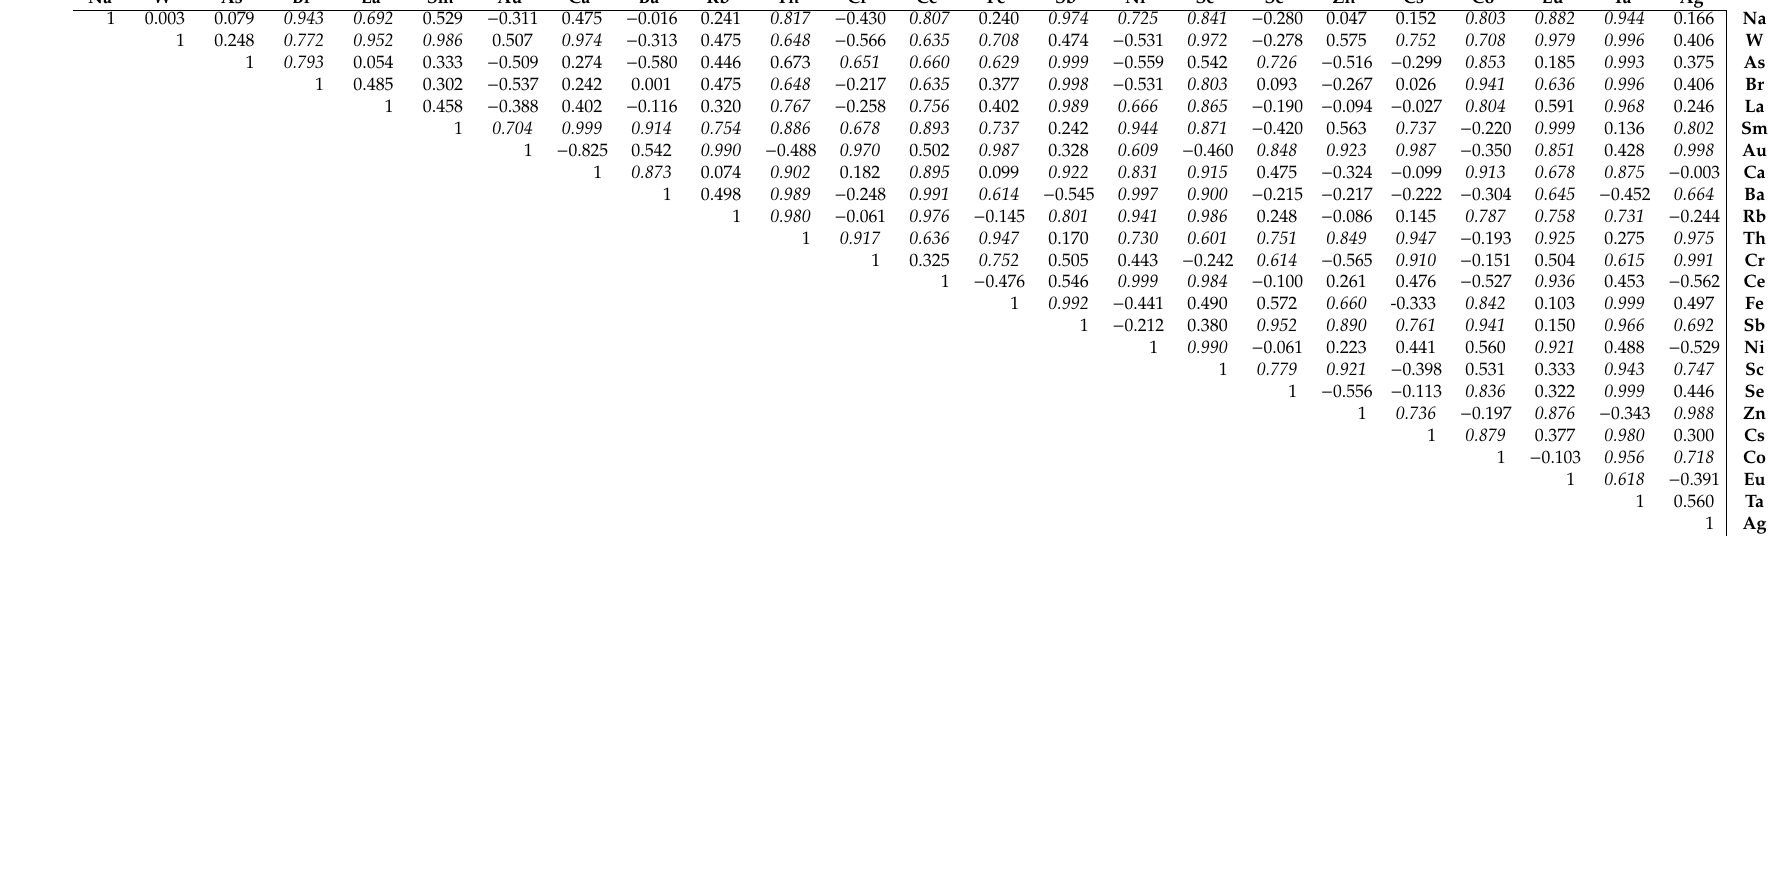
Table 4. Element Pearson’s correlation between the di ff erent PM-fractions (PM 2.5 vs. PM 10 ; PM 1 vs. PM 10 ; PM 1 vs. PM 2.5 ). In italics are reported the correlations > 0.6. Na